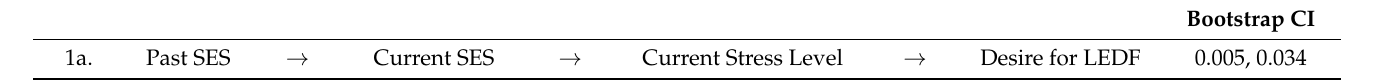
Table 3. The indirect effect of past (childhood) SES on low-energy-dense food